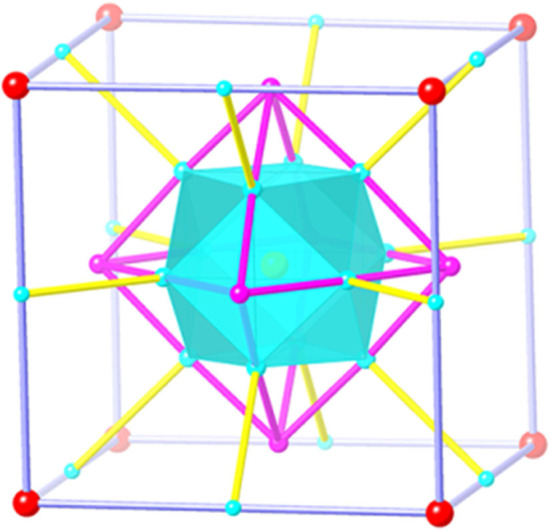
The topology of three-shell {(MCu12O8)(Cu12XmOn)(Nb7(OH)O21)8} polyanion [M = Nb (1), Nb (2), Ln (3); X = I (1, m = 3, n = 3; 2, m = 5, n = 1), Br (3, m = 5, n = 1)] in compound 1, 2, and 3. M, yellow ball; Cu, cyan ball; X/O, purple ball, [Nb7(OH)O21]8: red ball.